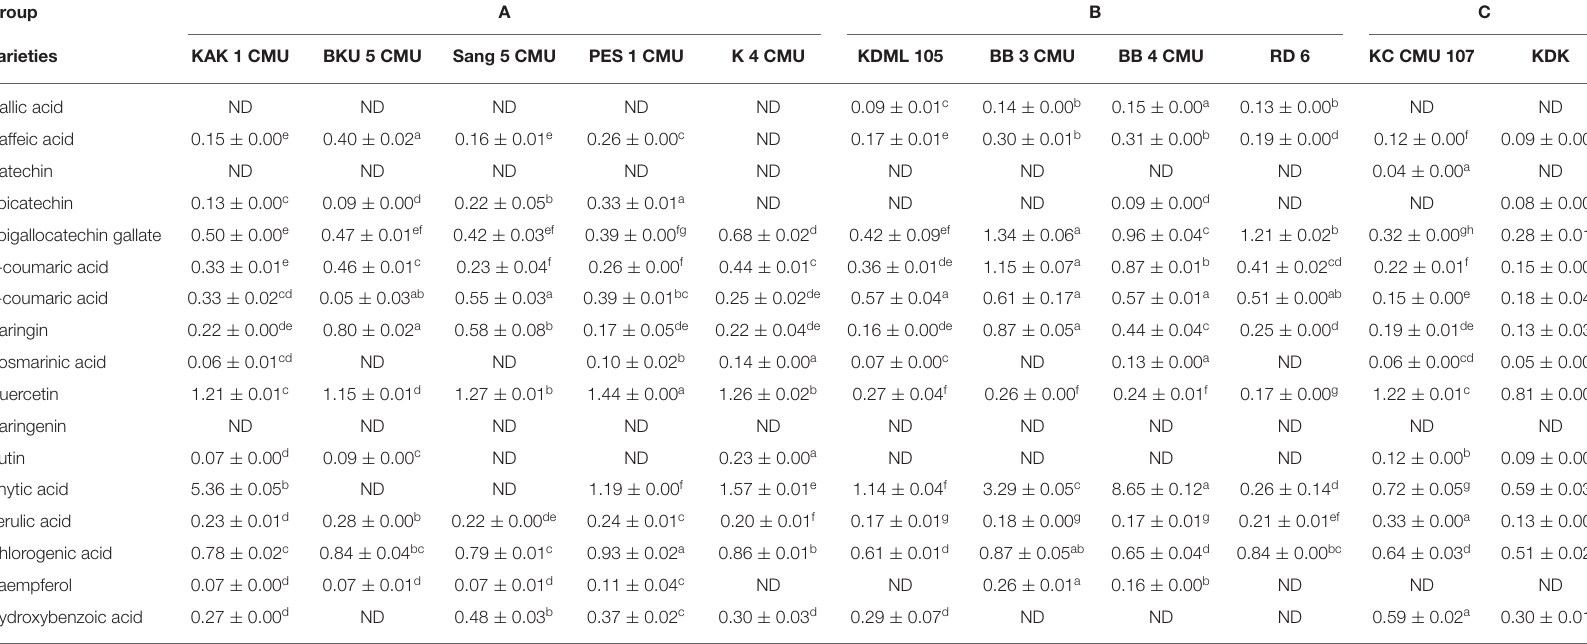
TABLE 7 | Phenolic contents in different varieties of rice bran (mg/100g